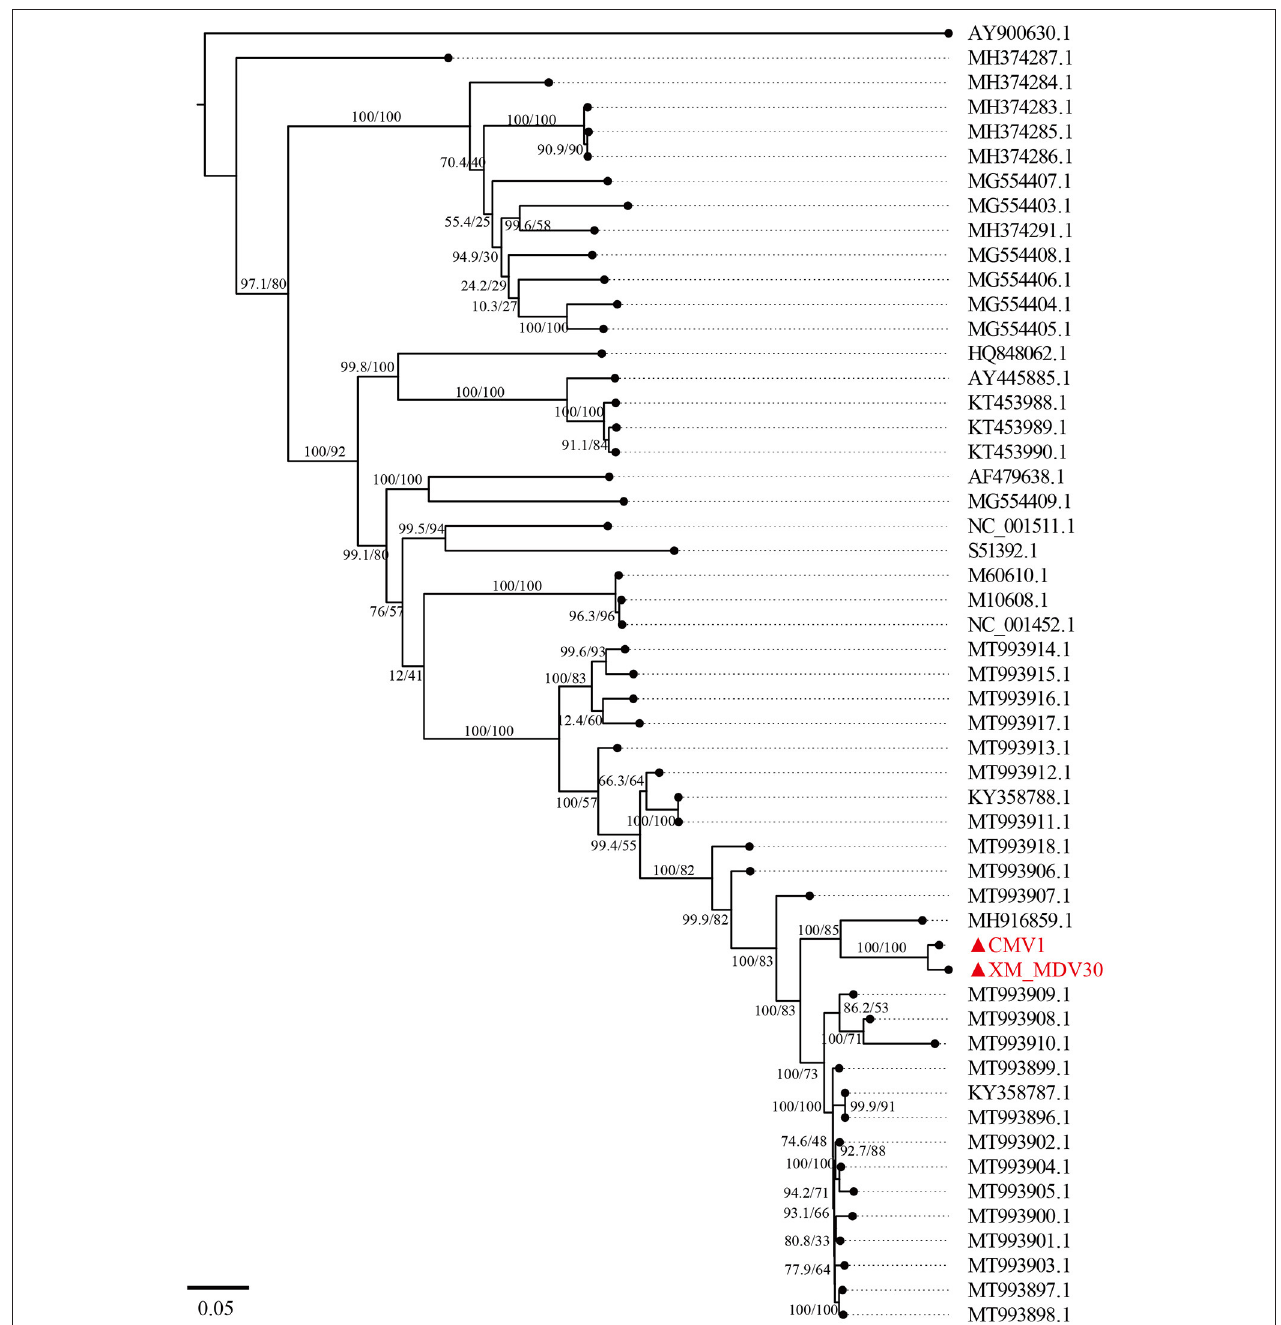
FIGURE 6 | A maximum-likelihood tree of Visna/Maedi virus based on whole-genome sequences. The genome sequences were only recruited the VMV-like strains (SRLVs genotype A). The VMV genomes sequenced in this study are marked with triangles and red